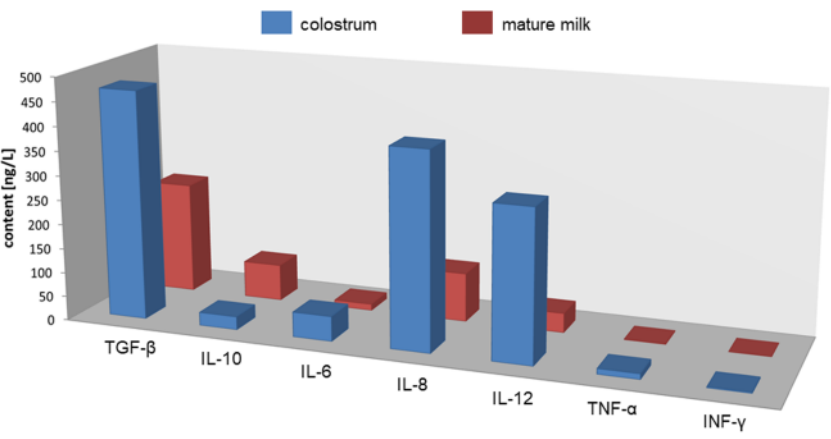
Figure 9. Cytokine concentrations in breast milk in different stages of lactation.